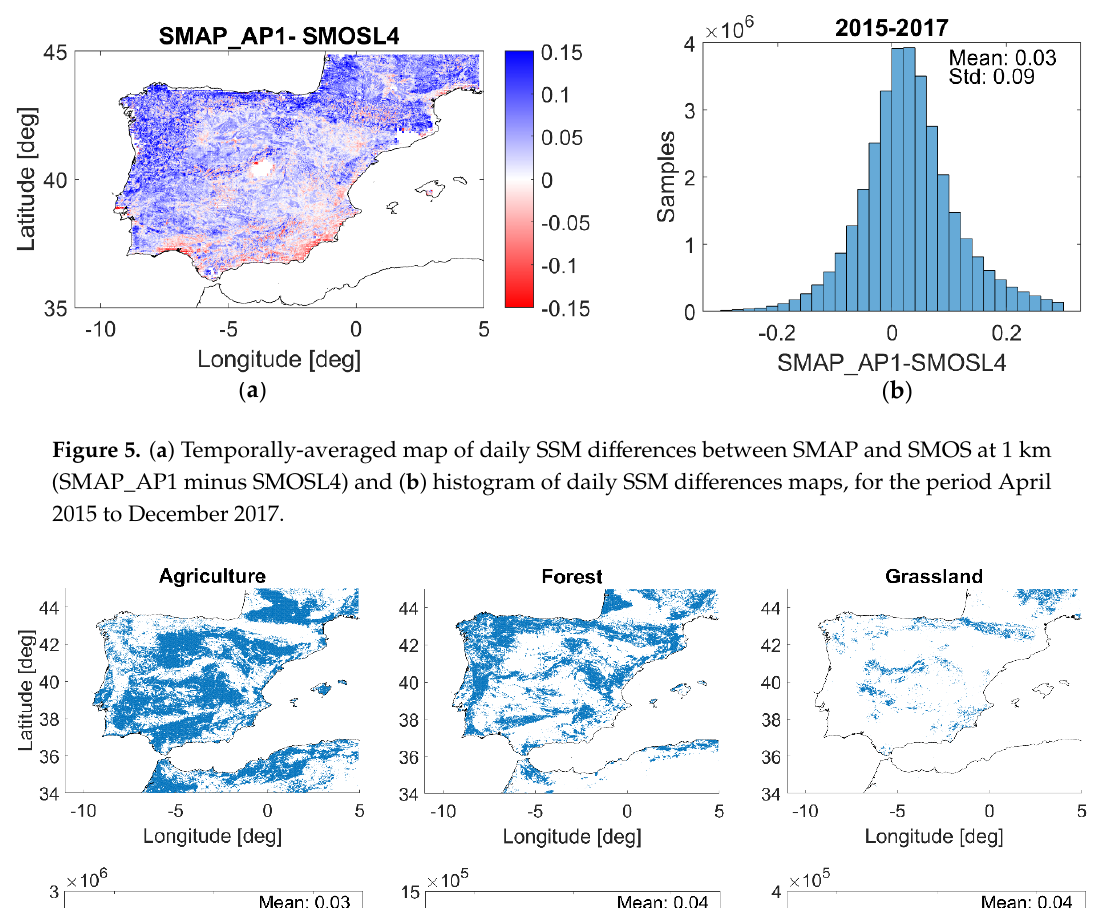
13 of 21 Figure 4. Temporally-averaged map of daily SMAP ( a ) and SMOS ( b ) products at 1 km over the Iberian Peninsula for the period December 2016 to February 2017.